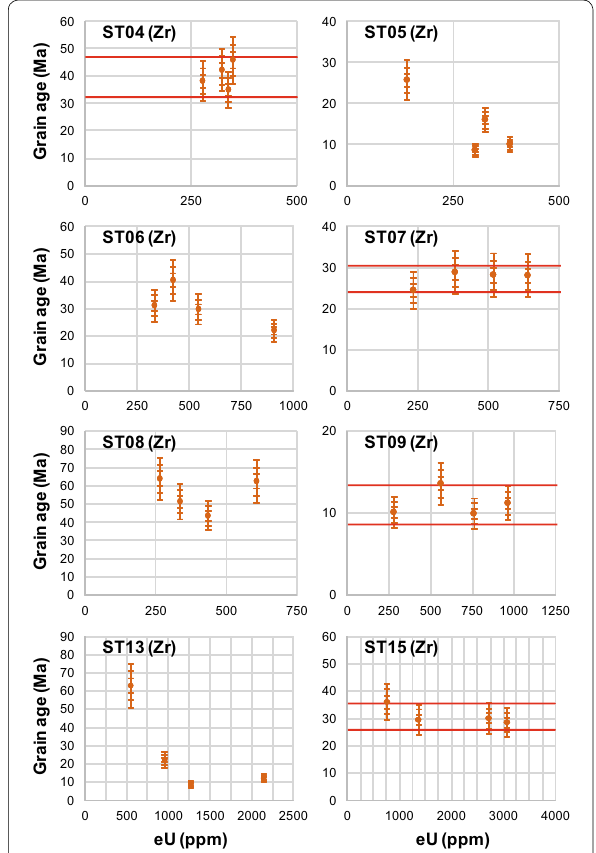
Fig. 2 Effective uranium (eU) versus (U–Th)/He grain age of zircon. The vertical error bars denote the horizontal red lines indicate the weighted mean age dence interval (CI) and